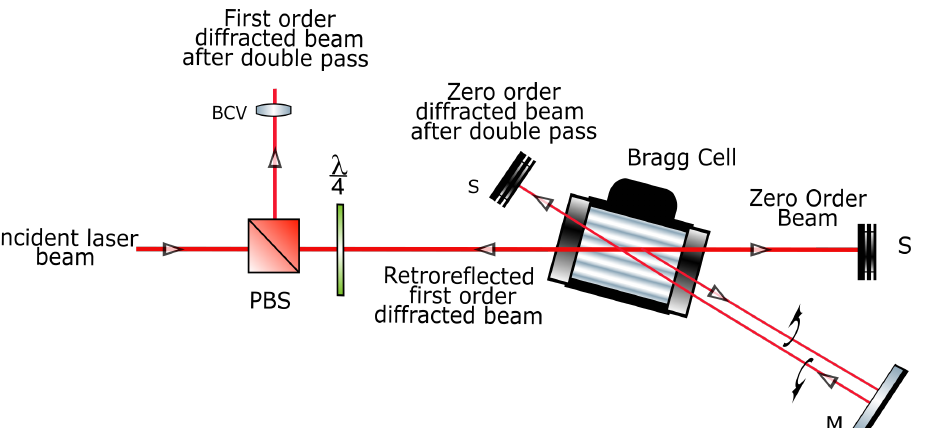
Figure 2. Double pass configuration optical setup. The incident and retroreflected beams, using a mirror (M), are orthogonally circularly polarized due to the presence of the quarter-wave plate λ , and they are separated through the polarizing beam splitter (PBS). In both the incident and retroreflected beam, the zeroth order beams are blocked using a beam stop (S).